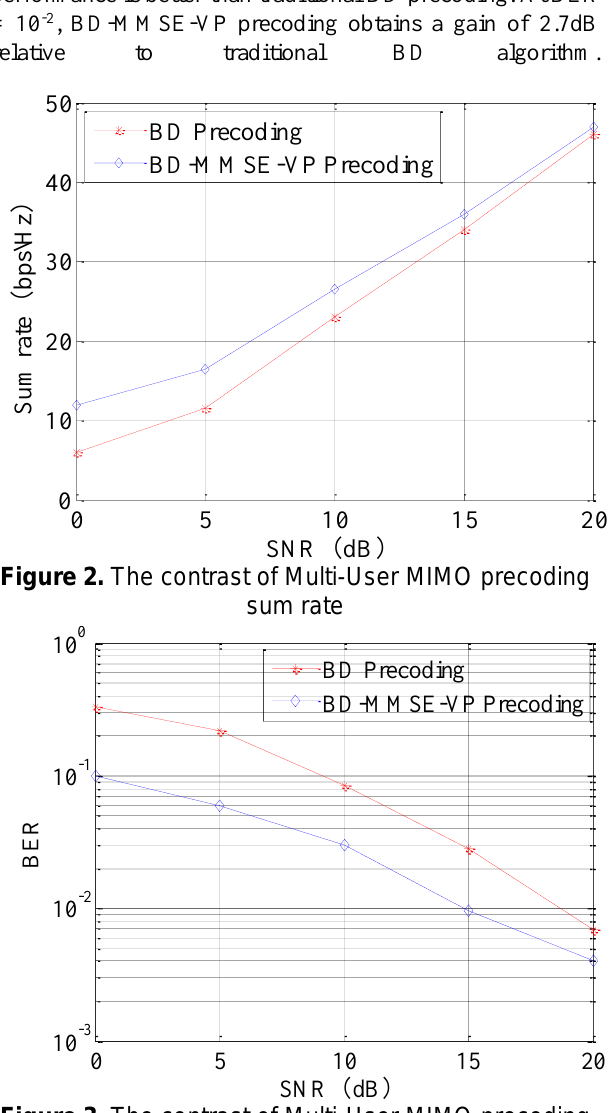
Figure 3. The contrast of Multi-User MIMO